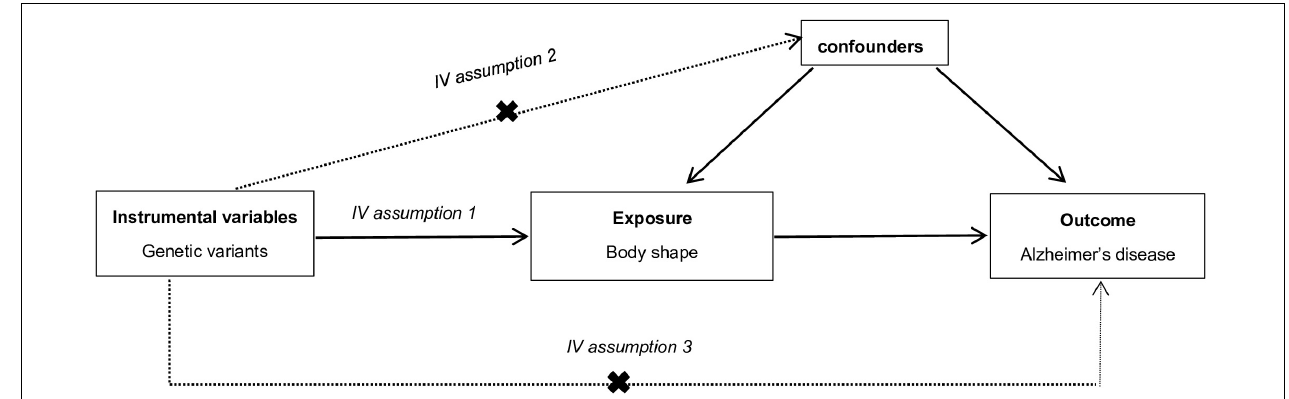
FIGURE 1 | The explanation of Mendelian randomization analysis by a directed acyclic graph. The accuracy of estimating causality using Mendelian randomization (MR) analyses is based on the following three assumptions: (1) The instrumental variable (IV) associate robustly with the exposure (IV assumption 1). This assumption can be satisfied by ensuring F statistic > 10 and that SNPs are selected using genome-wide significance levels ( P < 5 × 10 − 8 ), which suggests that potential bias from weak IV should not be substantial (Nordestgaard et al., 2017). (2) The IV is independent of combined influence of all confounders (IV assumption 2). For the same population and reference, we assess correlation of linkage disequilibrium between SNPs associated robustly with exposure and SNPs linked to possible known confounders. If the correlation coefficient is higher (i.e., r 2 ≥ 0.5), the corresponding selected SNPs will be discarded (Geng et al., 2018). (3) The IV is independent of the outcome given the exposure and confounders (IV assumption 3). Horizontal pleiotropy, that IVs influence the outcome through alternative pathways other than the exposure, could violate this assumption. It can be checked by using MR-Egger regression and MR-PRESSO method (Noyce et al., 2017; Verbanck et al., 2018).